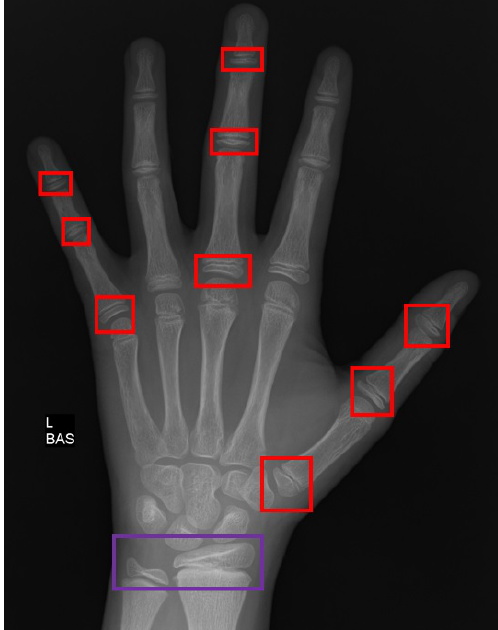
Figure 1. Regions of interest used in Tanner–Whitehouse assessment, which are indicated by the red and purple bounding boxes. The red boxes represent the regions of interest of the phalanges bones, while the purple box indicates the region of interest for the carpal